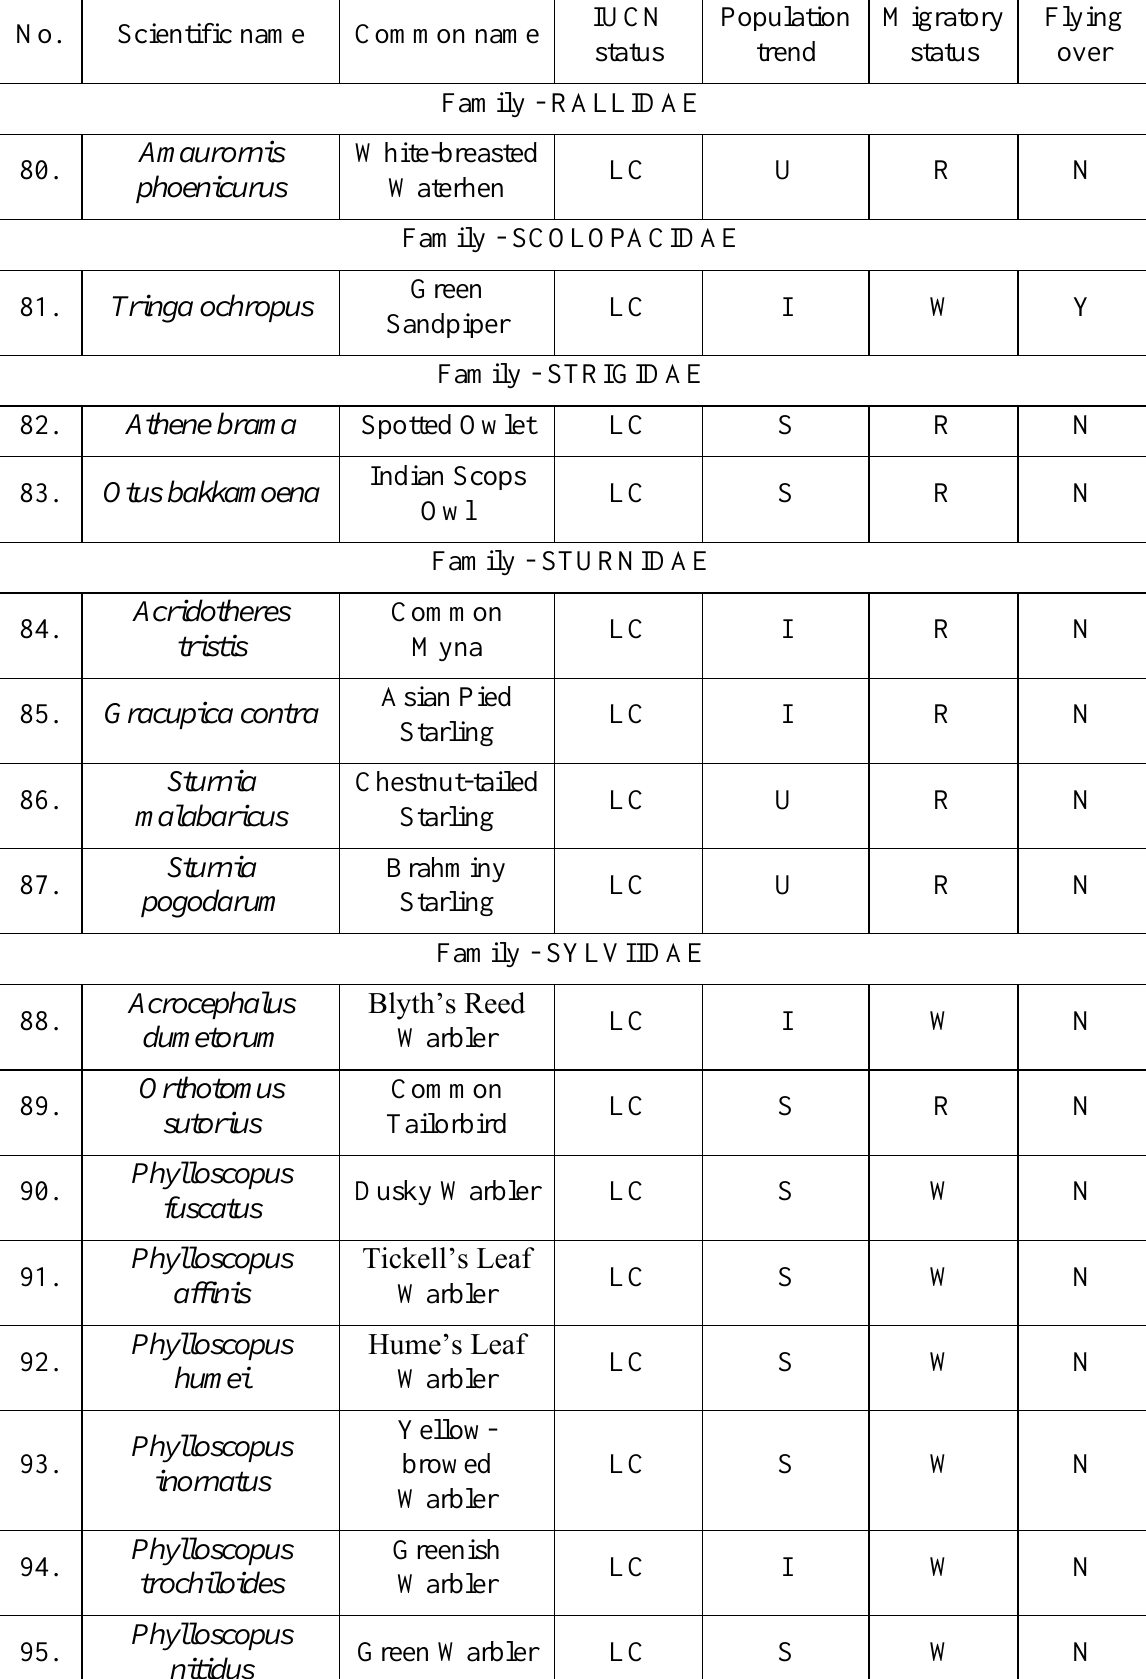
Table 1. List of bird species recorded in Durgapur Government College Campus (continued)